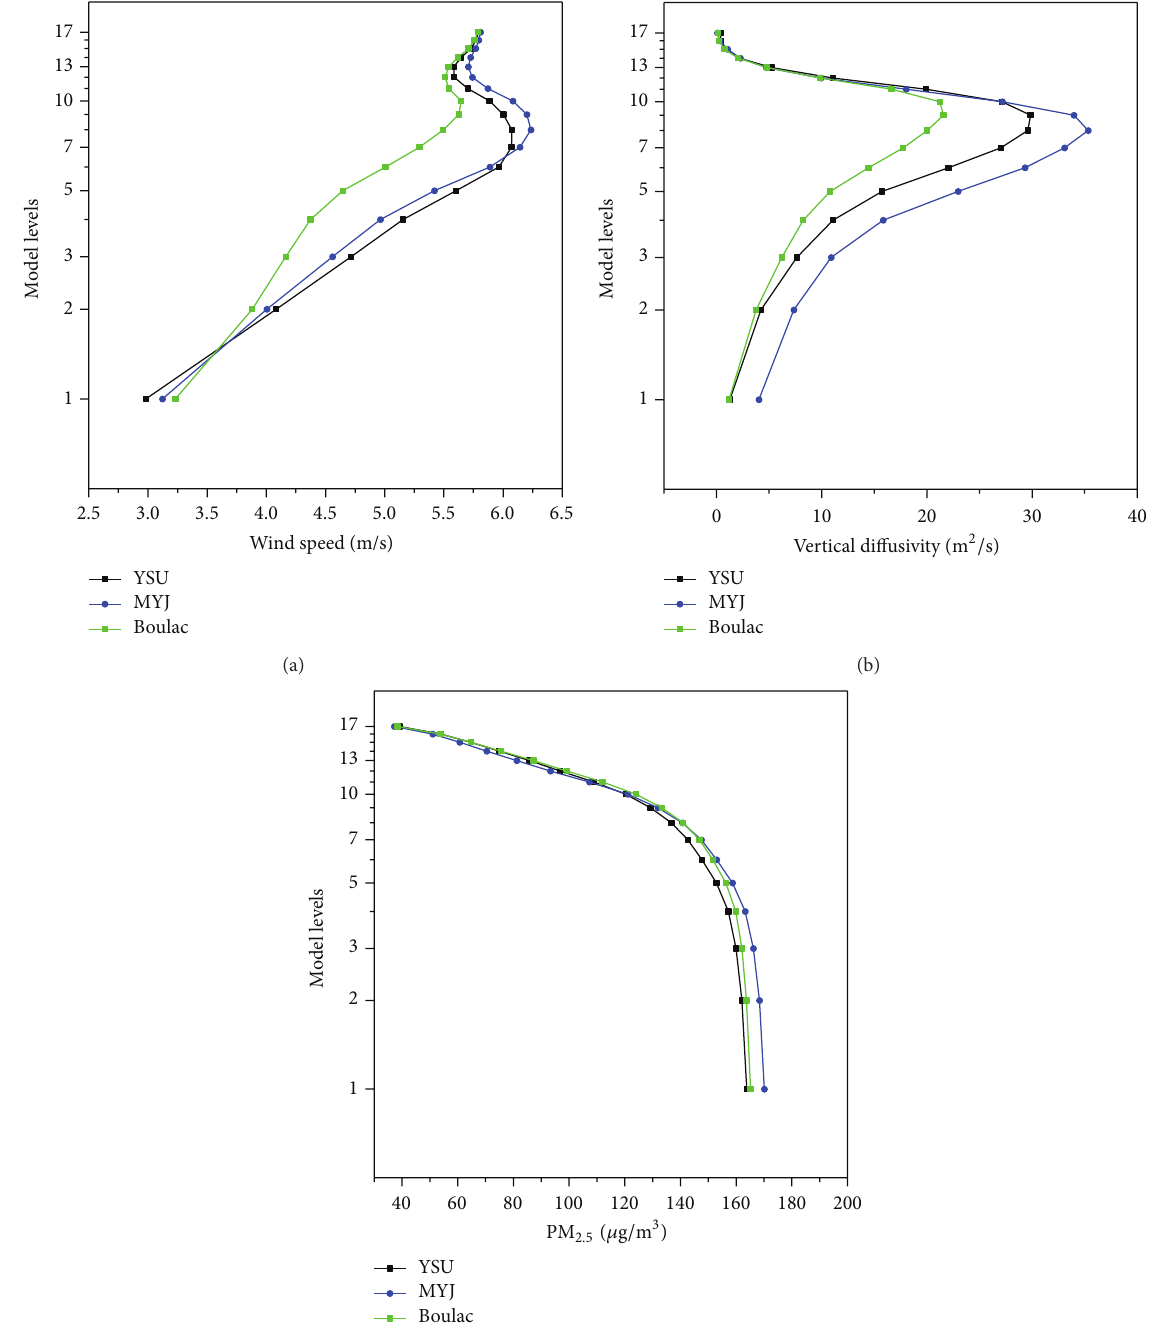
Figure 7: Vertical profiles of wind speed (a), vertical diffusivity (b), and PM 2.5 concentration